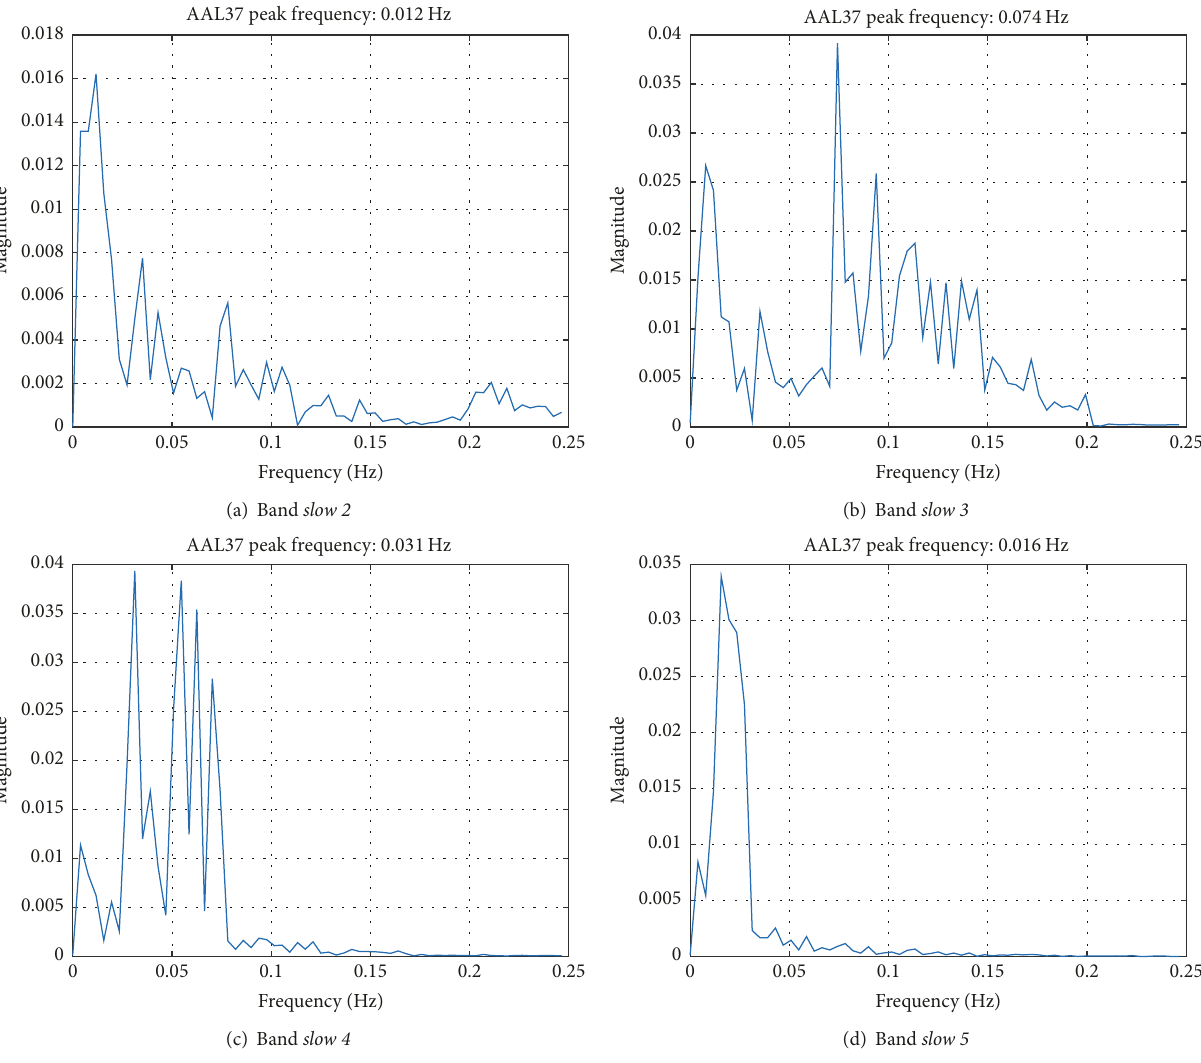
Figure 1: FFT for BOLD signals (for convenience, only the hippocampus of the first subject in each group is shown; the results of other ROIs and subjects are quite